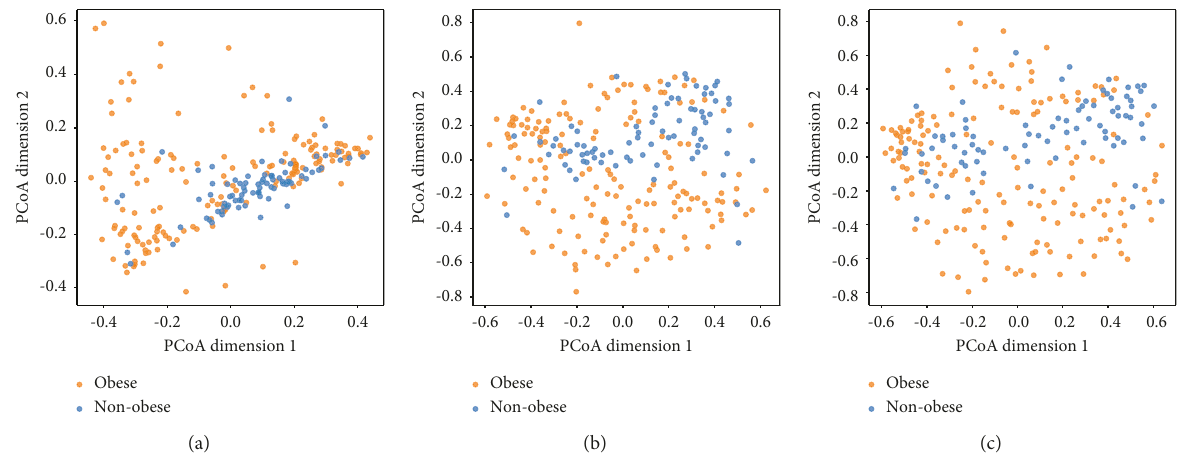
Figure 1: Beta-diversity of bacterial phylum (a), family (b), and genus (c) in obese and nonobese children. PCoA based on Bray–Curtis dissimilarity was performed with the observation showing no significant difference at the phylum level; however, there were significant differences in gut microbial community structure at the family and genus levels between obese and nonobese children ( P � 0 . 012 and P � 0 . 003). It should be noted that parts of these observations could be due to differences in sample processing and choice of hypervariable region between our study and previous works. Obese children are shown in orange; nonobese children are shown in blue. PCoA: principal coordinate